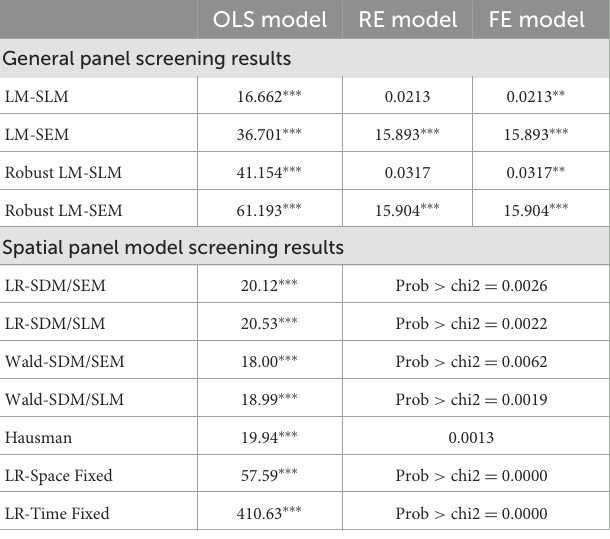
TABLE 3 Spatial econometric model screening results.